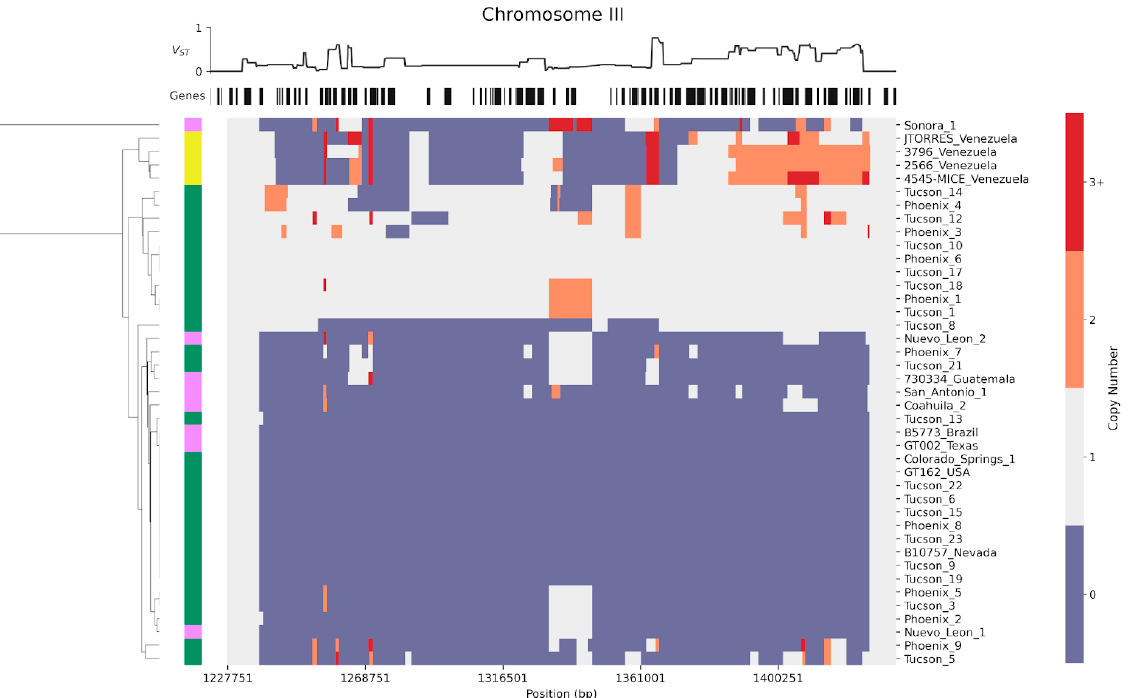
Figure 4. Widespread deletions in a spherule-expressed locus. In the main panel, data are as in Figure 3 and Supplementary Figure S3, except that only a region of chromosome III is shown, and strains were clustered using Euclidean distance and average linkage. For a version showing windows overlapping transposons, see Supplementary Figure S4. Cells on the left report strain population: Arizona, green; Caribbean, yellow; Texas/Mexico/South America, pink. The 78 coding genes of the chromosome III region included 15 spherule-induced genes (falling into two separately identified spherule-gene islands; Figure 2) and another 9 genes induced in hyphae. This constituted a strong enrichment of spherule-induced genes across the region relative to the null expectation (Fisher’s two-sided test p = 0.008). Most salient among the annotated genes at this locus (Supplementary Table S6) were an inferred polysaccharide synthase for the spherule capsule; a patatin-like phosopholipase; a hemolysin; and a ferric reductase—all orthologs of known or suspected factors mediat- ing interactions with the host in other fungal [43–45]. These functions established the chro- mosome III region as a compelling example of a putative virulence island with presence– absence variation across the species. Investigating the architecture of the chromosome III region, we noted extensive se- quence similarity in some pairs of coding genes encompassed by the locus (Figure 5 and Supplementary Note). We inferred that each such match represented a case of paralogy generated by a local duplication. This included a stretch of seven contiguous genes; a stretch of two contiguous genes; and a single duplicated gene, each present in two copies within the region in Silveira (Figure 5 and Supplementary Note). Sequence identities of the gene pairs in Silveira ranged from 68% to 100% in non-gapped regions (Figure 5). Transposons were positioned throughout the chromosome III region and at its boundaries (Supplementary Figure S4), plausibly acting as drivers of rearrangements across strains. We likewise assessed homology of each gene of the chromosome III region in C. immitis , the sister species to C. posadasii , finding C. immitis orthologs for most genes of the locus (Supplementary Table S6). Approximately half of the genes had homologs in a more distant relative, U. reesii (Supplementary Table S6) . These data supported a picture in